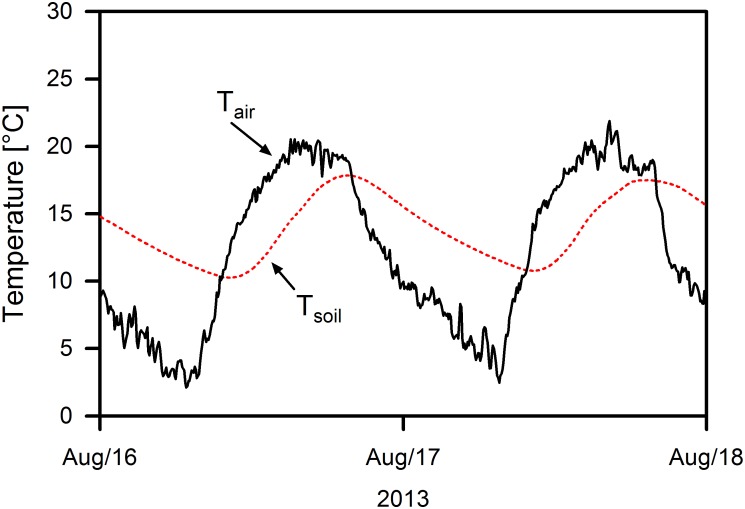
Daily fluctuation of air and soil temperature at 1 cm depth in a Kobresia sward at Kema Research Station (Tibetan Plateau, 4400 m a.s.l.) on 2 days in August 2013.